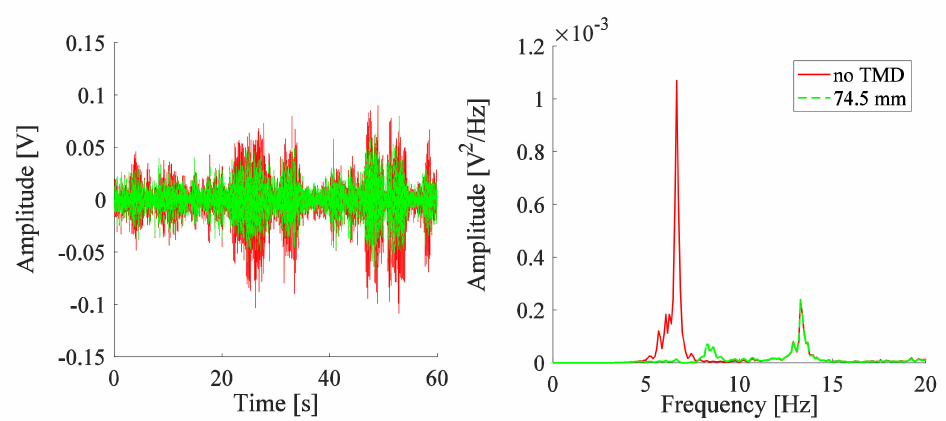
Figure 5. Responses measured by vibrometer for the system with one TMD for screw at a position reflecting the tuning frequency of the